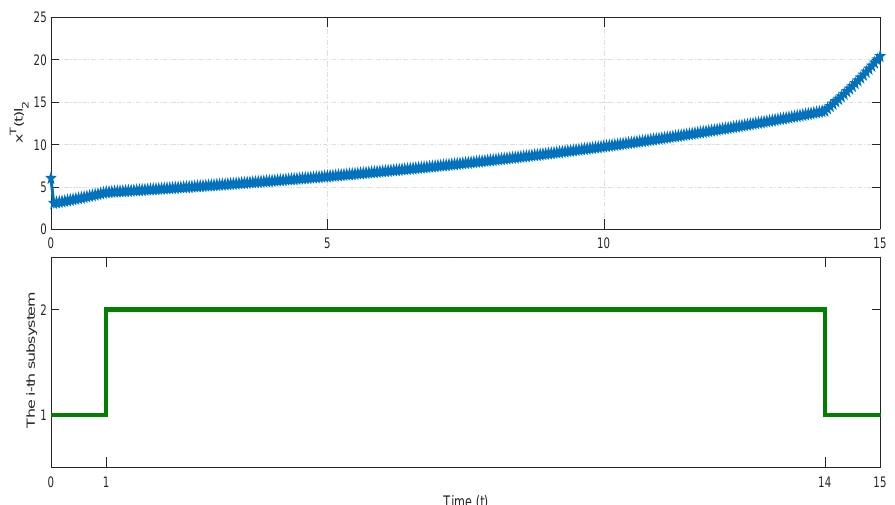
Figure 6. The value of x T ( t ) l 2 of the system in Example 2 under the corresponding switching